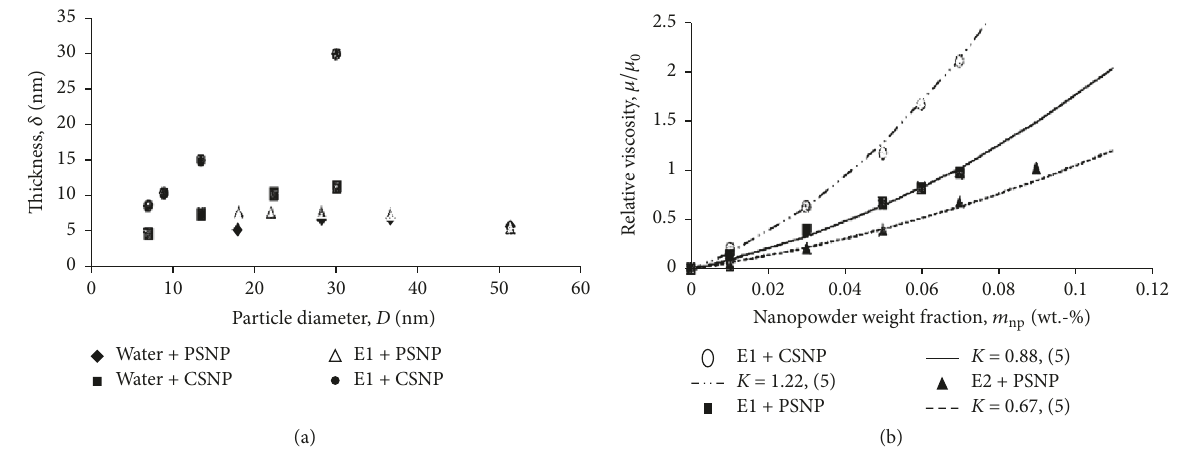
Figure 4: Comparative relations: (a) “particle size, thickness of the particle associated layer,” and (b) “concentration of the nanopowder, viscosity of a liquid composition,” due to different diffusion ability of the CSNP and PSNP.